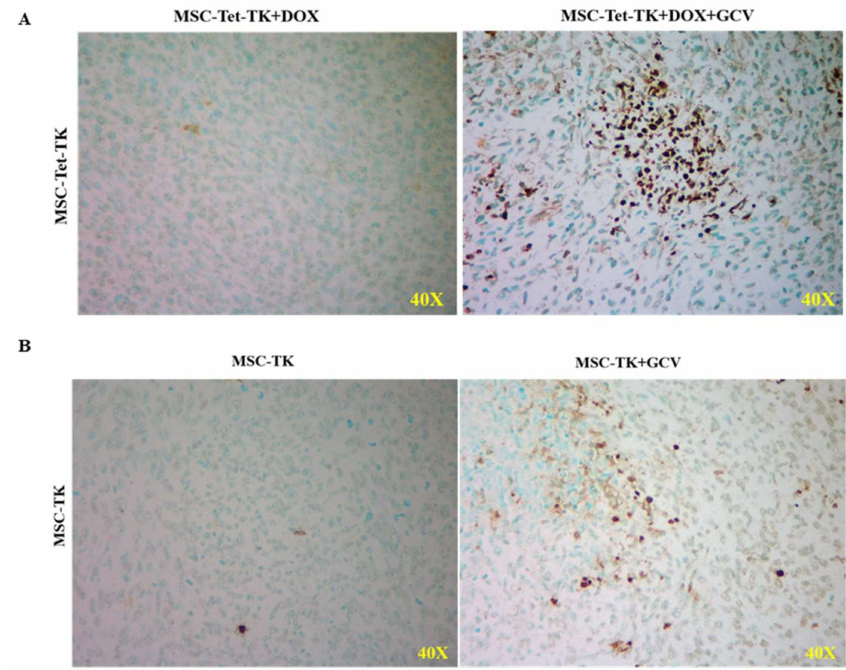
Figure 5. In vivo therapeutic effect of the MSC-Tet-TK and MSC-TK cells to induce colon tumor apoptosis in the presence of GCV. ( A ) Terminal deoxynucleotidyl transferase (TdT) dUTP Nick-End Labeling (TUNEL) assay for tumors taken from mice treated with MSC-Tet-TK DOX cells in the presence and absence of GCV. ( B ) TUNEL assay for tumors taken from mice treated with MSC-TK cells in the presence and absence of GCV. Apoptosis of cells was detected in the ganciclovir-treated group using the ApopTag peroxidase in situ apoptosis detection